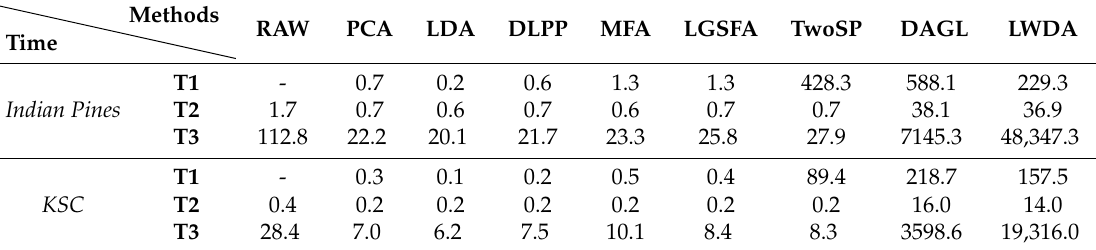
Table 5. Average computational time (unit: second) of different methods with NN classifier on the Indian Pines and KSC datasets using τ = 0.05.